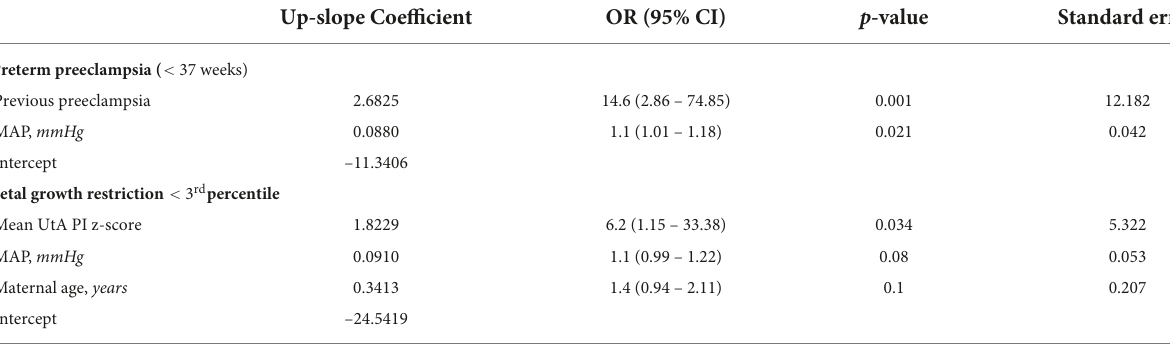
TABLE 3 Backward stepwise regression analysis for correlation between demographic and biophysical characteristics and presence of placental-mediated diseases. Up-slope Coefficient OR (95% CI) p -value Standard